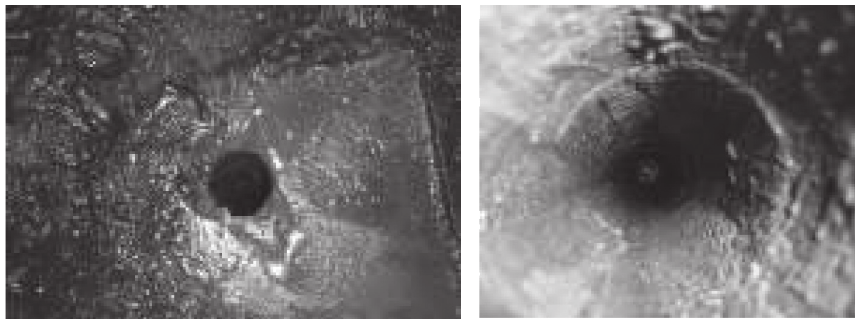
Figure 6: The effect of pumping reverse circulation drilling